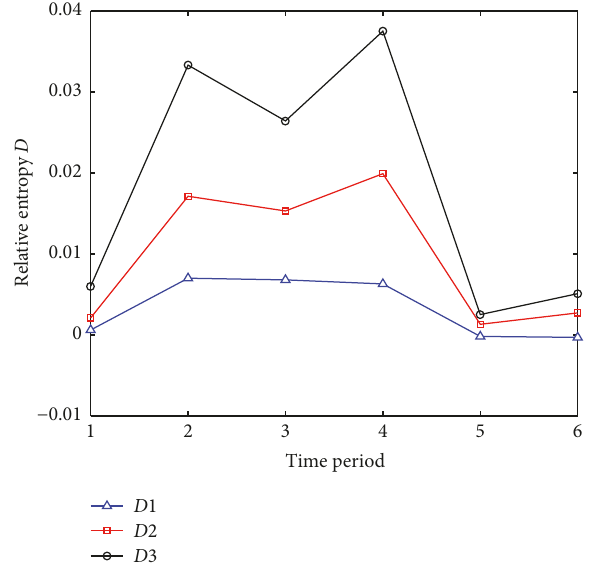
Figure 5: Relative Entropy 𝐷 of different periods ( 𝐷 1 refers to the Relative Entropy of 2-gram word length block, and so